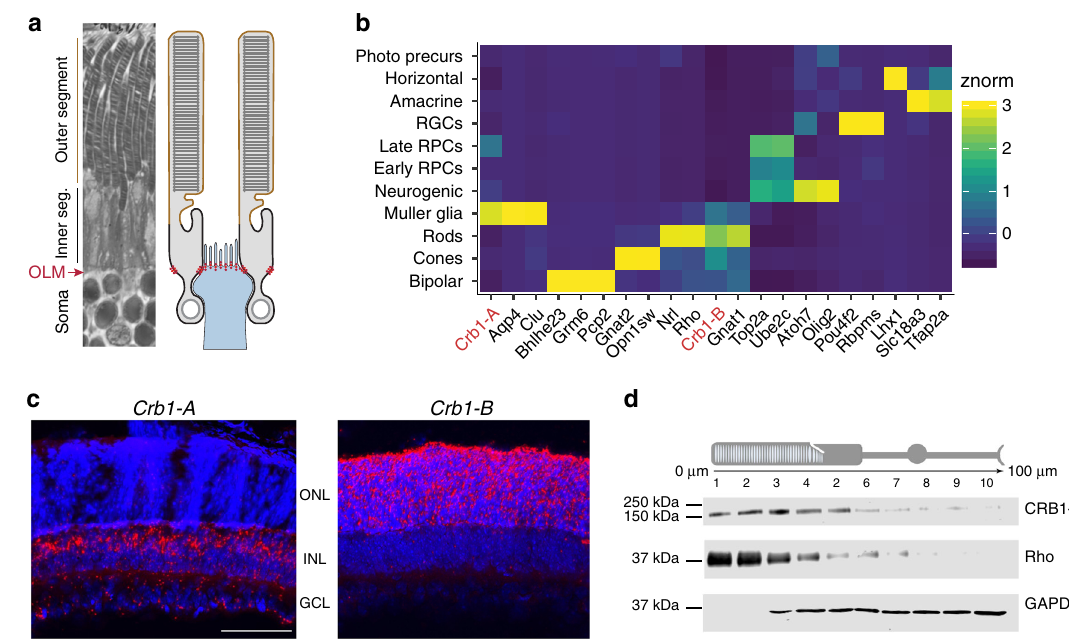
Fig. 8 CRB1-B is expressed by photoreceptors. a Schematic showing anatomy of outer retinal region where CRB1 is expressed. Left, photomicrograph depicting photoreceptor anatomy. Soma, inner segment (black), and outer segment (brown) regions are indicated. Outer limiting membrane (OLM; red arrow) separates soma layer from inner segment layer. Right, OLM anatomy schematic. OLM consists of junctions (red dots) between photoreceptors (gray) and Müller cells (blue). Junctions form selectively at particular subcellular domains of each cell type, i.e., glial apical membranes and photoreceptor inner segments. CRB1-A is expressed by Müller cells ( b , c ) where it localizes selectively to OLM junctions 51 . CRB1-B is expressed throughout the photoreceptor, including inner and outer segments ( b – d ). b Mapping of Crb1 isoforms in scRNA-seq data 50 . Heat map generated from gene pro fi les of >90,000 cells, showing normalized expression of Crb1 isoforms and retinal cell type marker genes. Unsupervised clustering was used to de fi ne genes co- expressed with Crb1 isoforms. Crb1-B clusters with known cone and rod photoreceptor genes, while Crb1-A clusters with known Müller glia genes. c BaseScope staining of P20 mouse retina cross-sections using isoform-speci fi c probes (red). Blue, Hoeschst nuclear counterstain. Crb1-A probe targeted exon 1-2 junction, which is also used by Crb1-A2 and Crb1-C (see Fig. 5A). Signal is primarily limited to central INL, where Müller cell bodies reside (left). Crb1-B probe targeted the junction between its unique 5 ′ exon and exon 6 (Fig. 5A). Signal is limited to photoreceptors within ONL. ONL outer nuclear layer, INL inner nuclear layer, GCL ganglion cell layer. Scale bar, 100 μ m. d Subcellular localization of CRB1-B within rod photoreceptors, assessed by Western blotting of serial 10 µ m tangential sections through mouse outer retina. Each lane corresponds to photoreceptor cellular compartment denoted by cartoon at top. Rhodopsin (Rho, center) is an outer segment marker; GAPDH (bottom) is excluded from outer segment but is present throughout the rest of the cell. CRB1-B protein (top) is present in all compartments; expression is strongest in lanes corresponding to outer and inner segments. Also see Source Data fi